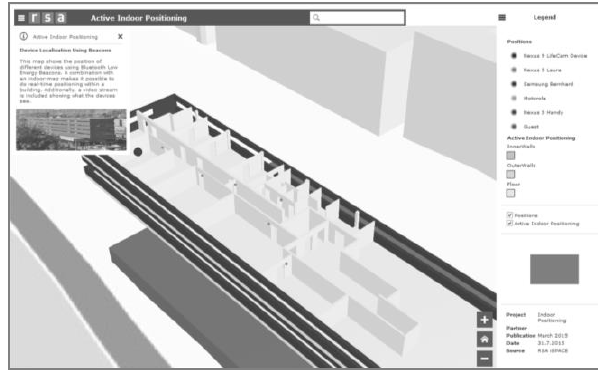
Figure 4. Prototypical